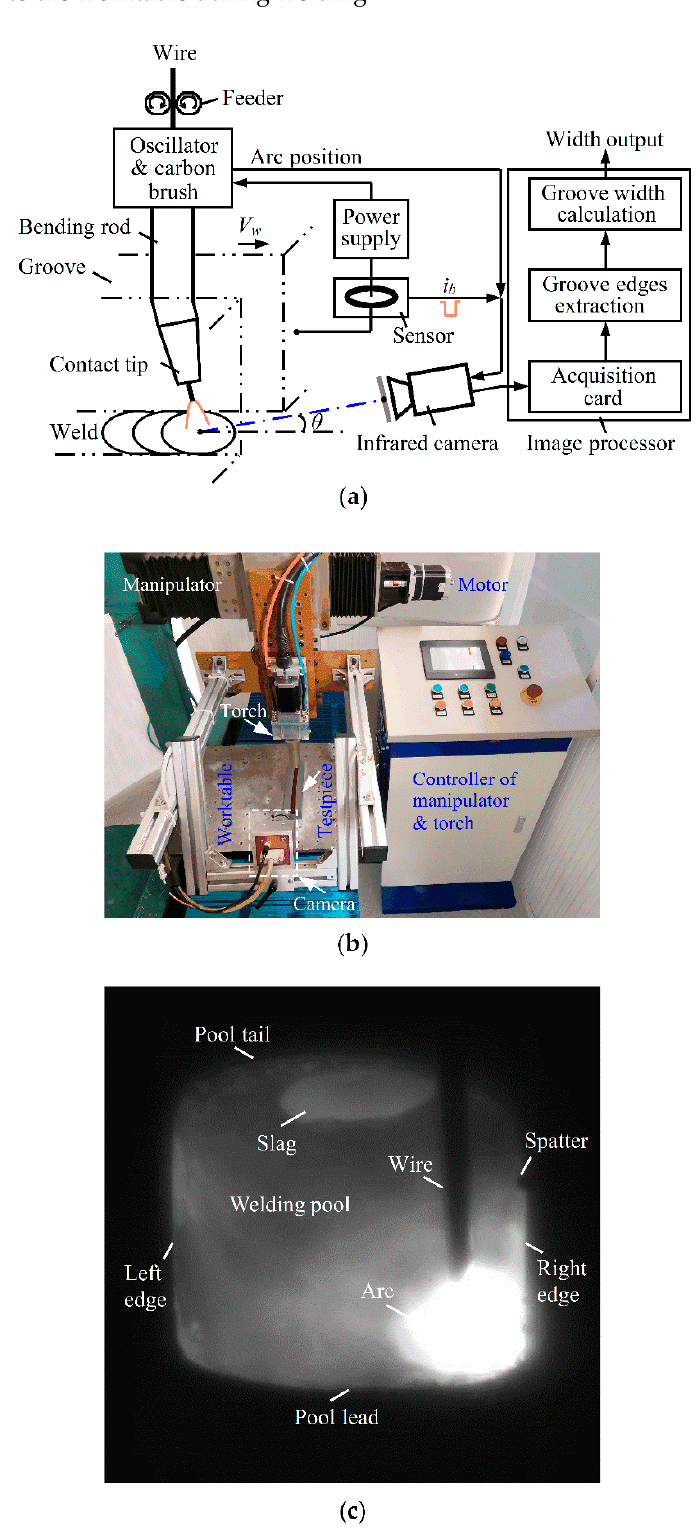
Figure 1. Principle of infrared passive visual sensing detection system of groove width for swing arc narrow gap welding: ( a ) schematic configuration of system; ( b ) actual system photograph; ( c ) example of welding infrared